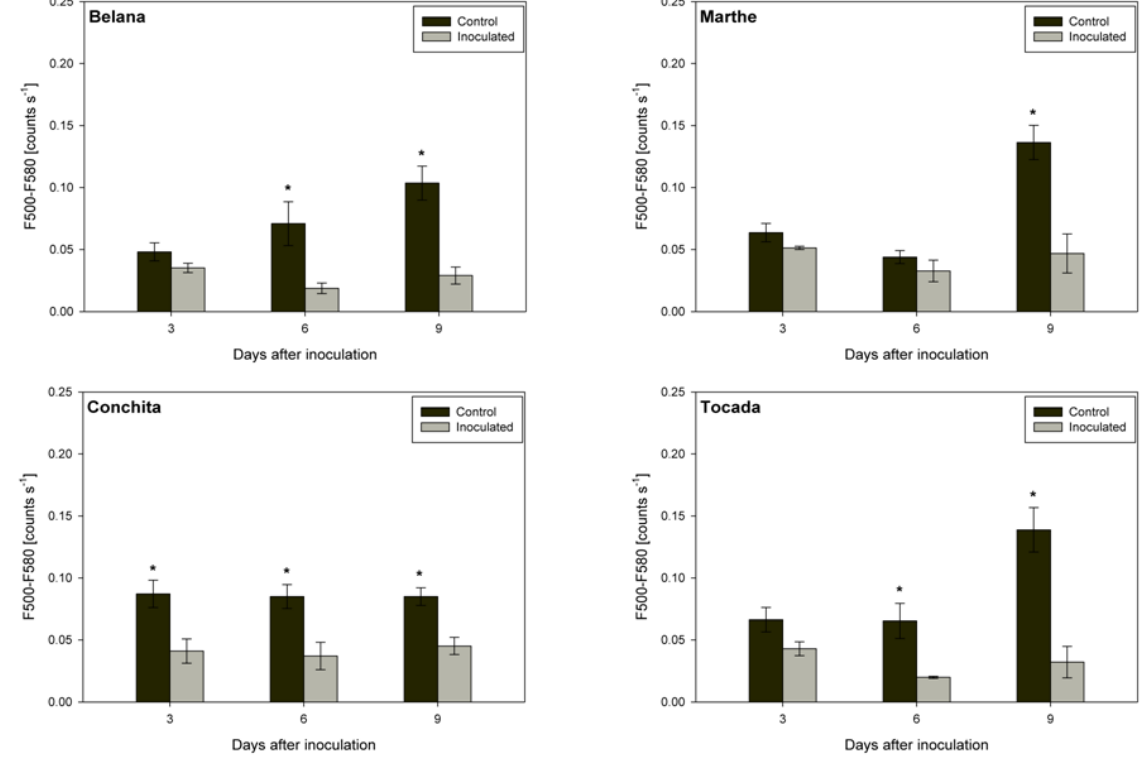
Figure 4. Green fluorescence intensity (500–580 nm scaled as counts s −1 ) recorded under blue excitation. Leaves of the healthy control and leaf rust inoculated plants, of the barley varieties Belana, Marthe, Conchita and Tocada were studied at 3, 6, 9 days after inoculation. Values indicate mean ± standard error ( n = 5). Asterisks (*) indicate significant differences ( t -test, p ≤ 0.05) between control and inoculated leaves for each variety and measuring day.